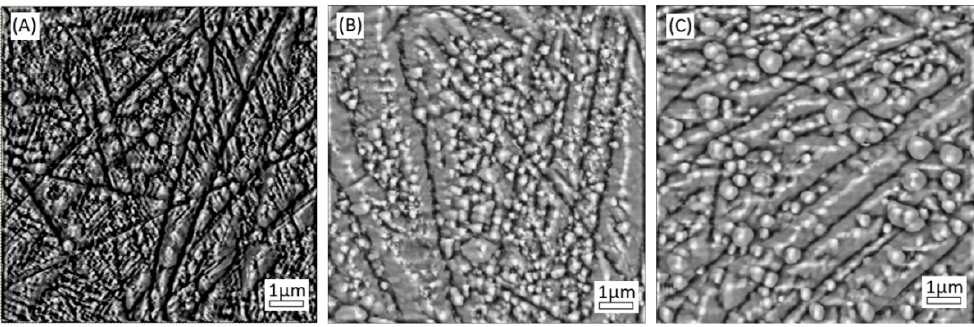
Figure 2. AFM micrograph of: Sample 0 ( A ), sample 1 ( B ) and sample 2 ( C ). Scan size 10 µm × 10 µm.